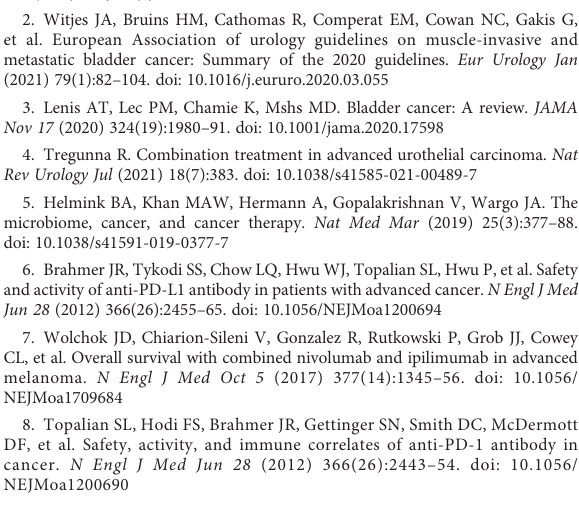
SUPPLEMENTARY TABLE 1 Data Source and Clinical